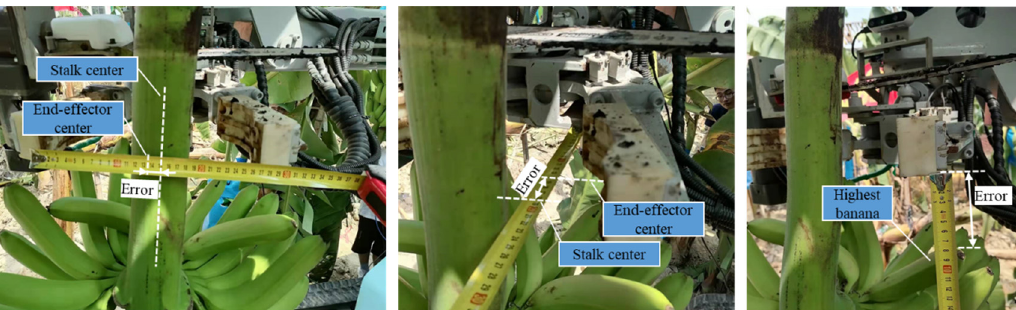
Figure 6. End-effector ( left ) and its tolerances in the width and depth directions ( right ).